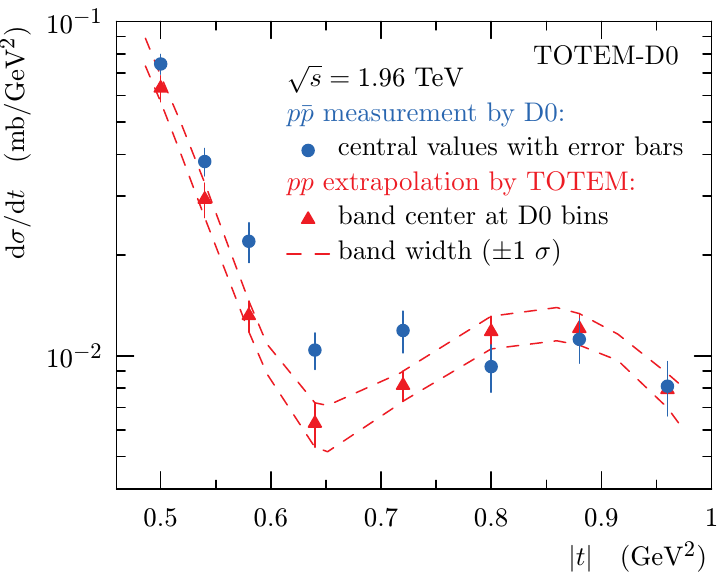
Figure 5: Comparison between the D0 p ¯ p measurement at 1.96 TeV and the extrap- olated TOTEM pp cross section, rescaled to match the OP of the D0 measurement. The dashed lines show the 1 σ uncertainty band on the extrapolated pp cross section. (Figure reproduced from Ref. [ 2 ]